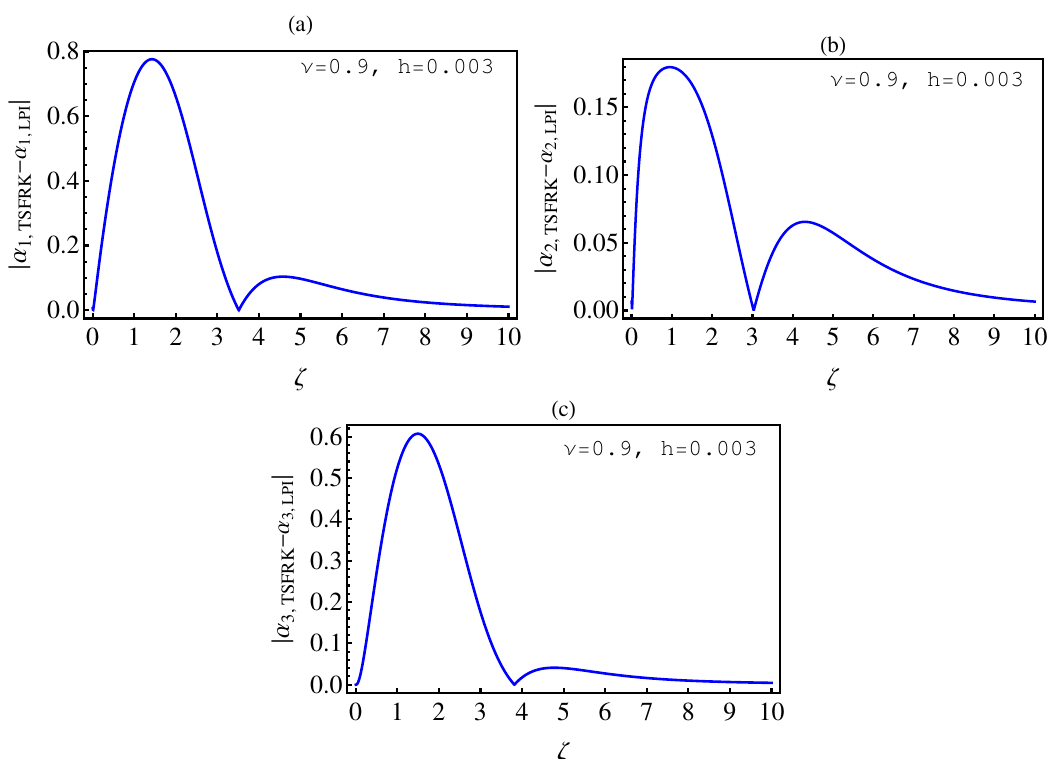
Figure 8. The absolute error between the numerical solutions of (2) to (4) based upon the LPI and the FSFRK for ν = 0.9, h = 0.03, m = 21, λ = 2, (cid:101) = 1, µ = 2, δ = 1 and for the initial values α 1 ( 0 ) = 0, α 2 ( 0 ) = 1 and α 3 ( 0 ) = λ (( a ), ( b ) and ( c ),